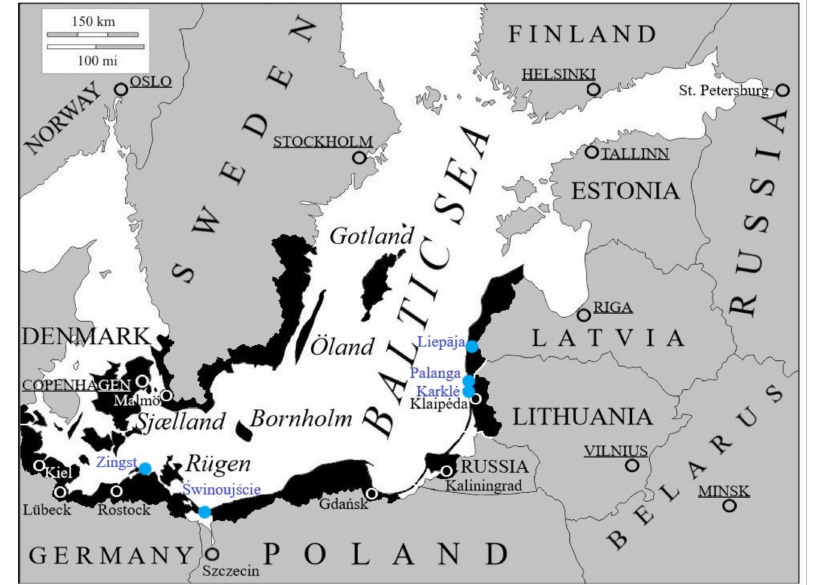
Figure 1. Map of the South Baltic Area with the target seaside and marine resorts (Plotted by Ram¯unas